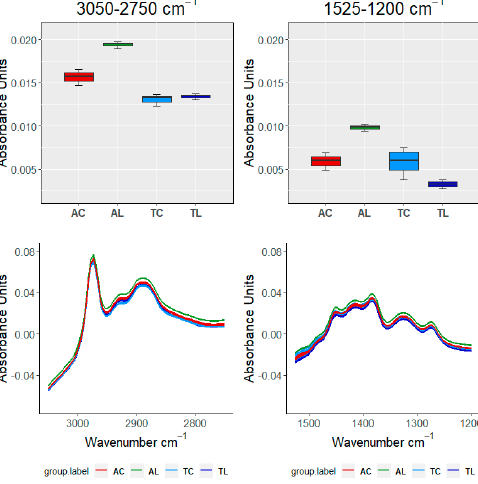
Figure 4. Plots of two of the four significant areas of the curves with an ageing time of 12 months. In the first row, vectorial analysis by means of boxplots. In the second row, FDA through curves in the studied interval. The wine spirit sample is divided into four groups (AC, AL, TC, and TL).